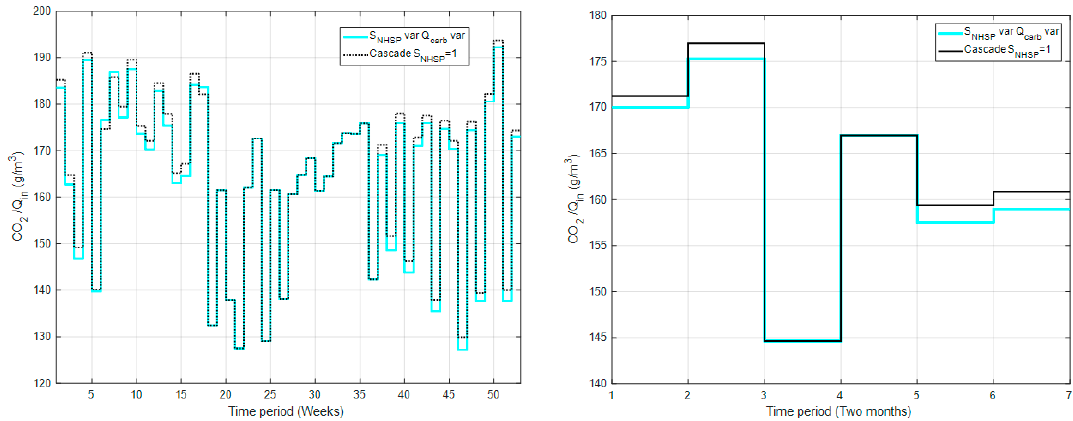
Figure 13. Weekly and bimonthly profile for total CO2 emissions (g / m3) indicators with Cascade S NHSP and the alternative strategy.